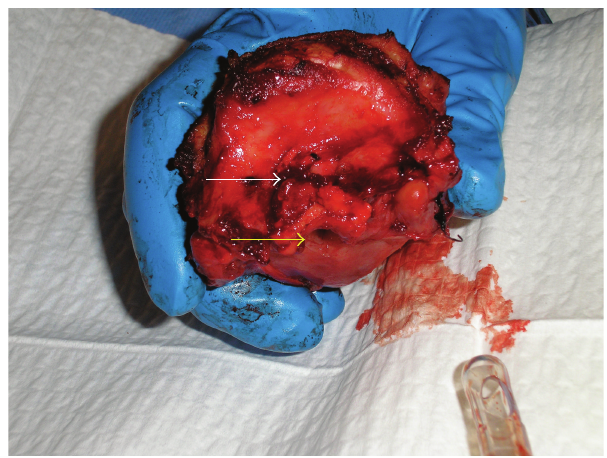
Figure 1: Larynx with tumour mass after dissection. White arrow: tumour mass. Yellow arrow: barely recognizable epiglottis and se- verely narrowed glottic opening. Tracheal tube size 6.0.